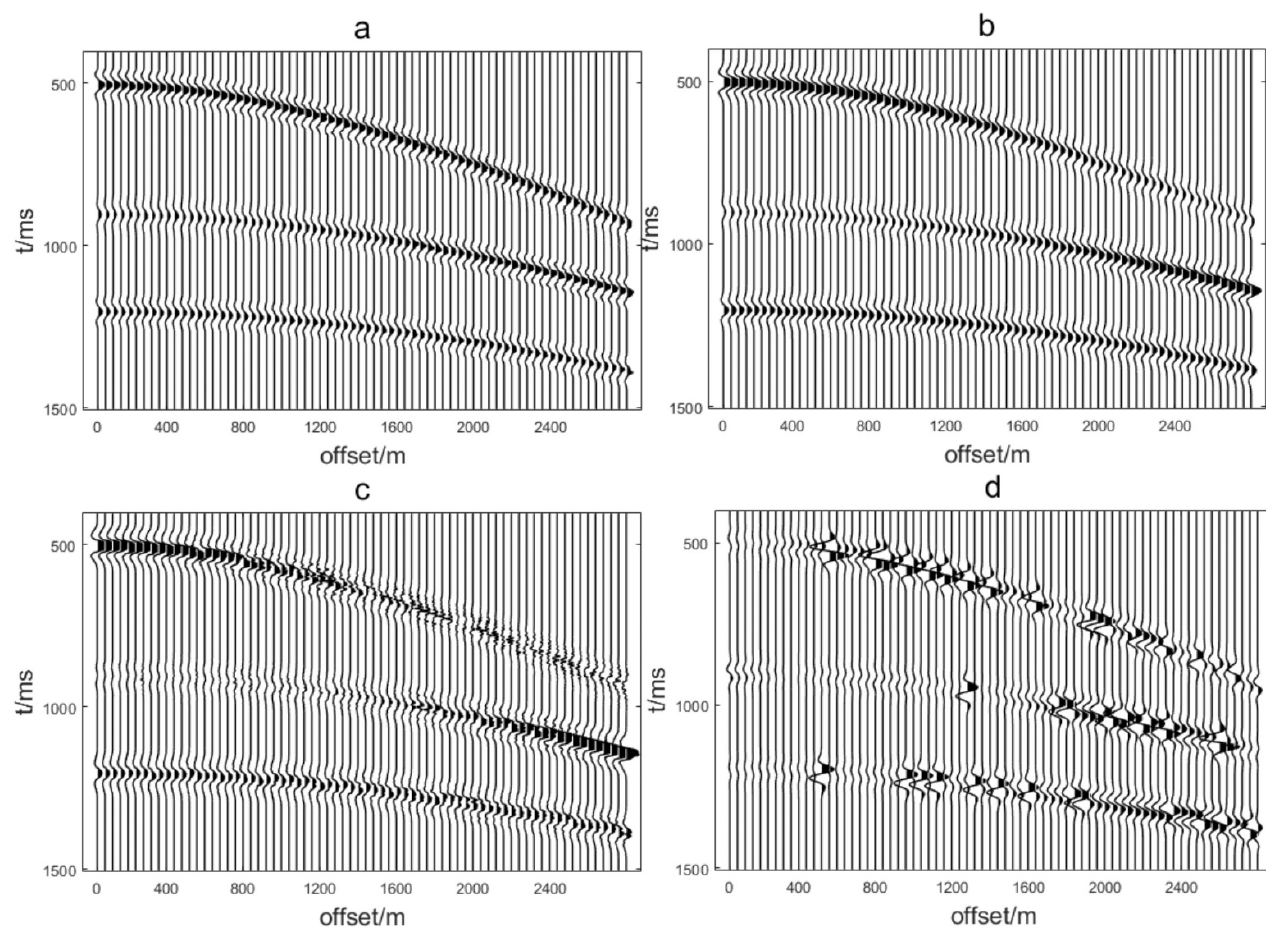
Figure 6. ( a ) Reconstruction result of the CGRT; ( b ) reconstruction result of the WRT; ( c ) reconstruction residual of the CGRT; ( d ) reconstruction residual of the WRT.